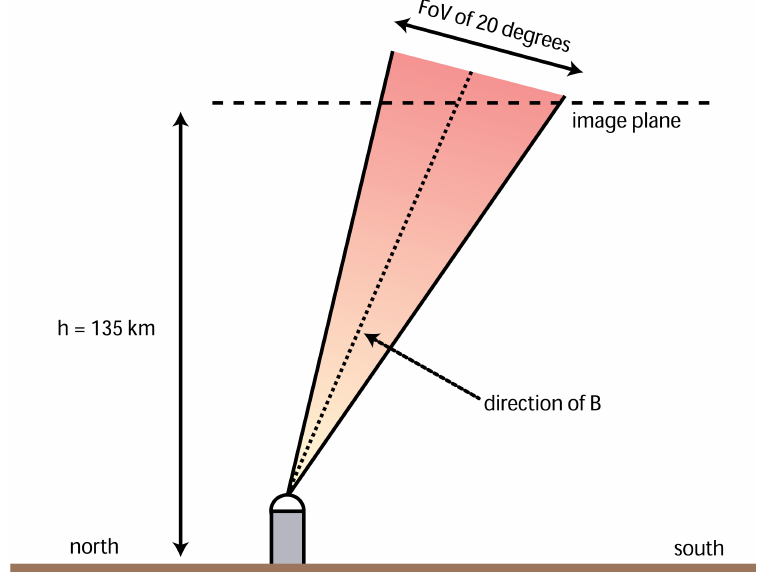
Fig. 4. A sketch of the FoV and its geometry. The camera is pointed in the direction of the local magnetic field with the zenith angle of 17.7 ◦ .